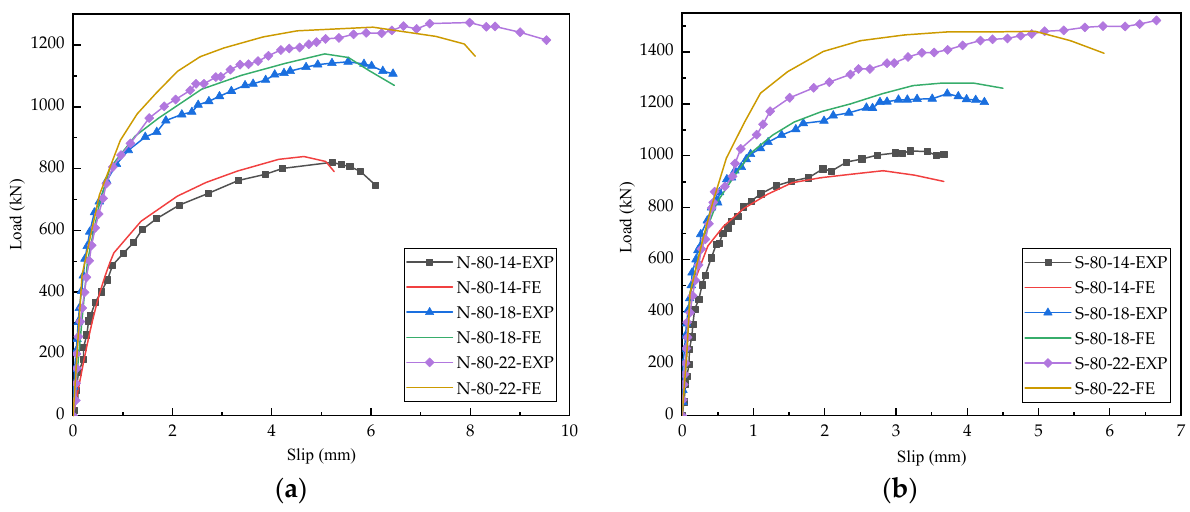
Figure 9. Load ‐ slip curves of static test and FE simulations: ( a ) NC; ( b ) SFRCC. Figure 9. Load-slip curves of static test and FE simulations: ( a ) NC; ( b )